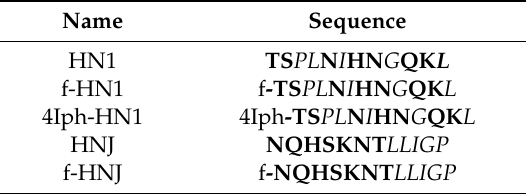
Table 1. Compound names and peptide sequences as single letter codes. Polar amino acids are in bold. f = Fmoc; 4Iph = 4-para-iodo-benzyl for HN17 series, and 4-para-iodo-benzoyl for HN1 series. Dyes are conjugated to lysine